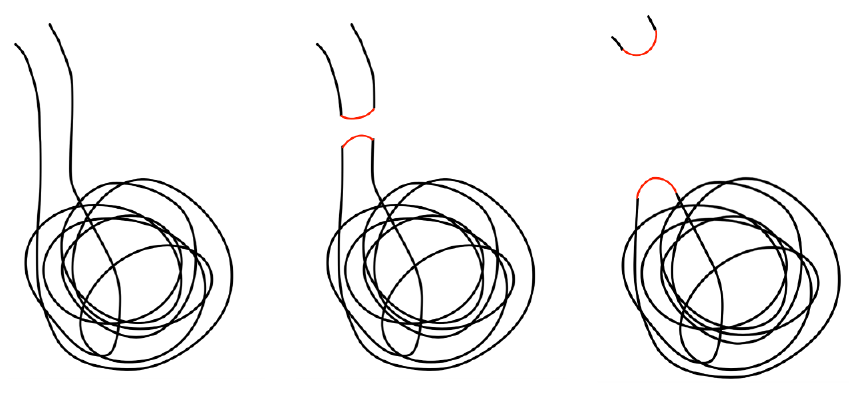
Figure 1. Dual gravity description of the ungauged D0-brane matrix model proposed by Maldacena and Milekhin. A long open string (left) can split to closed and open strings (middle). Then the open string can shrink toward the boundary, while the bight of the closed string can shrink toward the center